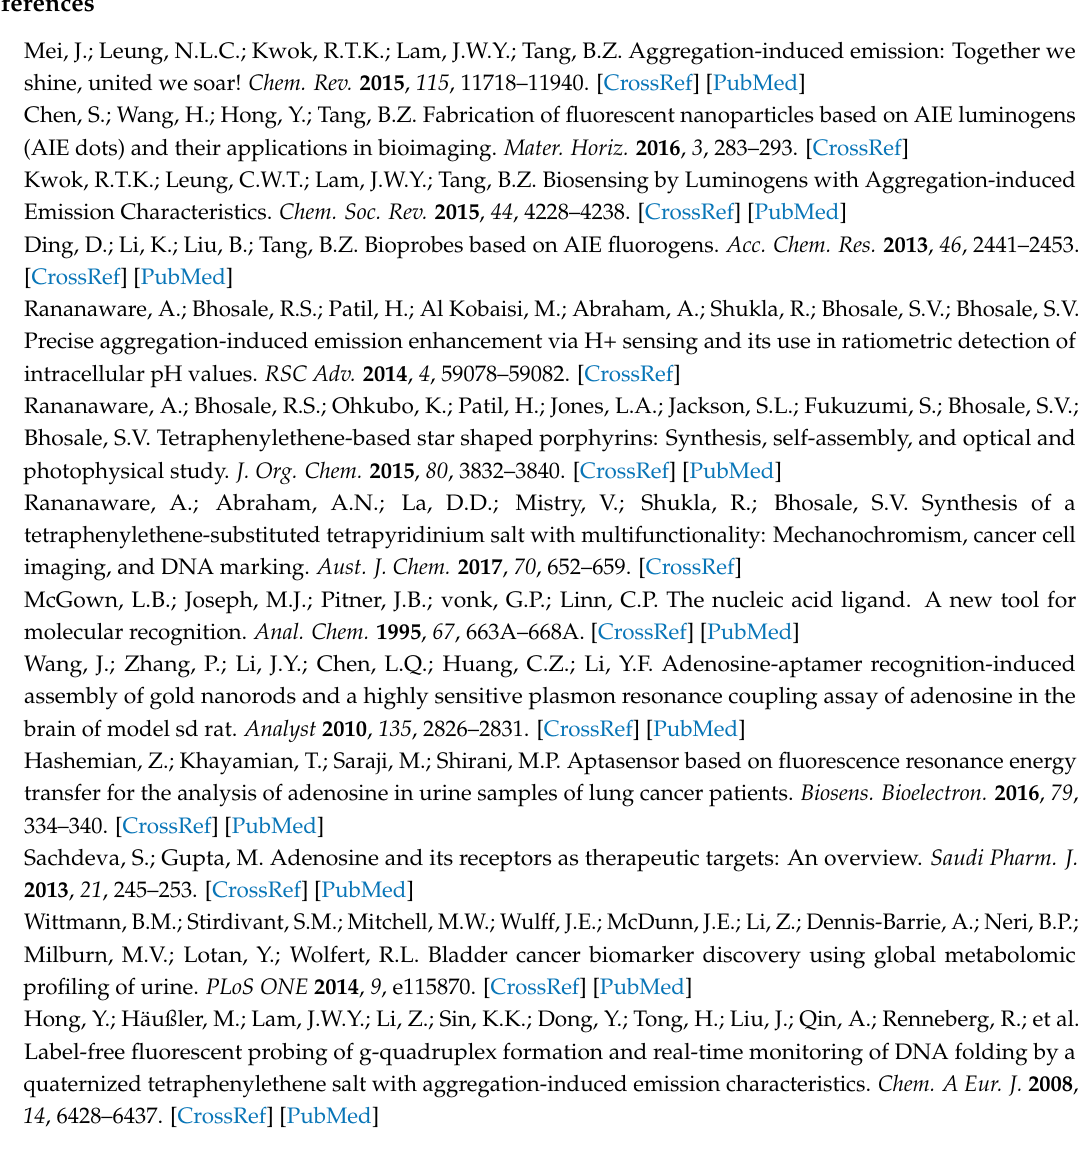
Table S1: The recipe of different concentrations of the TPE-2N+ solutions for the examination of the emission behavior of TPE fluorogen in Tris buffer; Table S2: The recipe for investigation of the viability of (TPE-2N+) + ABA probe; Table S3: The recipe of different concentrations of nucleotide samples for the specificity experiment; Table S4: The intra-day precision of the detection by the probe for urine samples; Table S5: The inter-day precision of the detection by the probe for urine